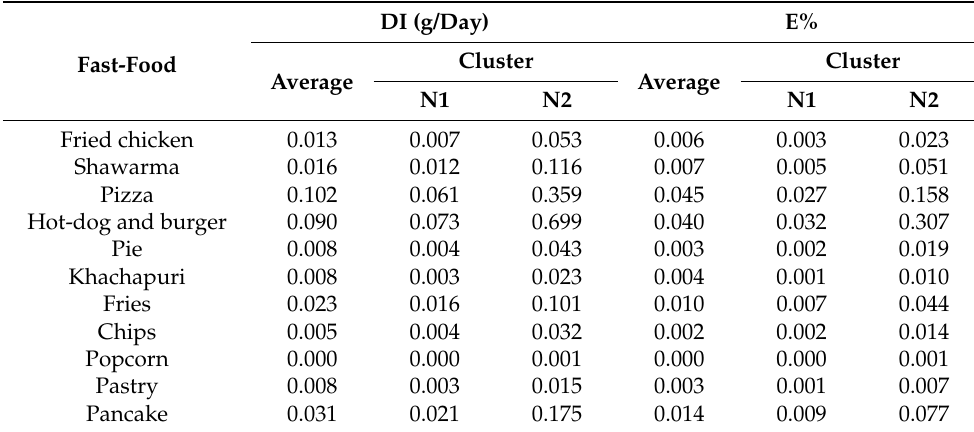
Table 1. DI of TFA (g/day), TFA intake as a % of total Energy